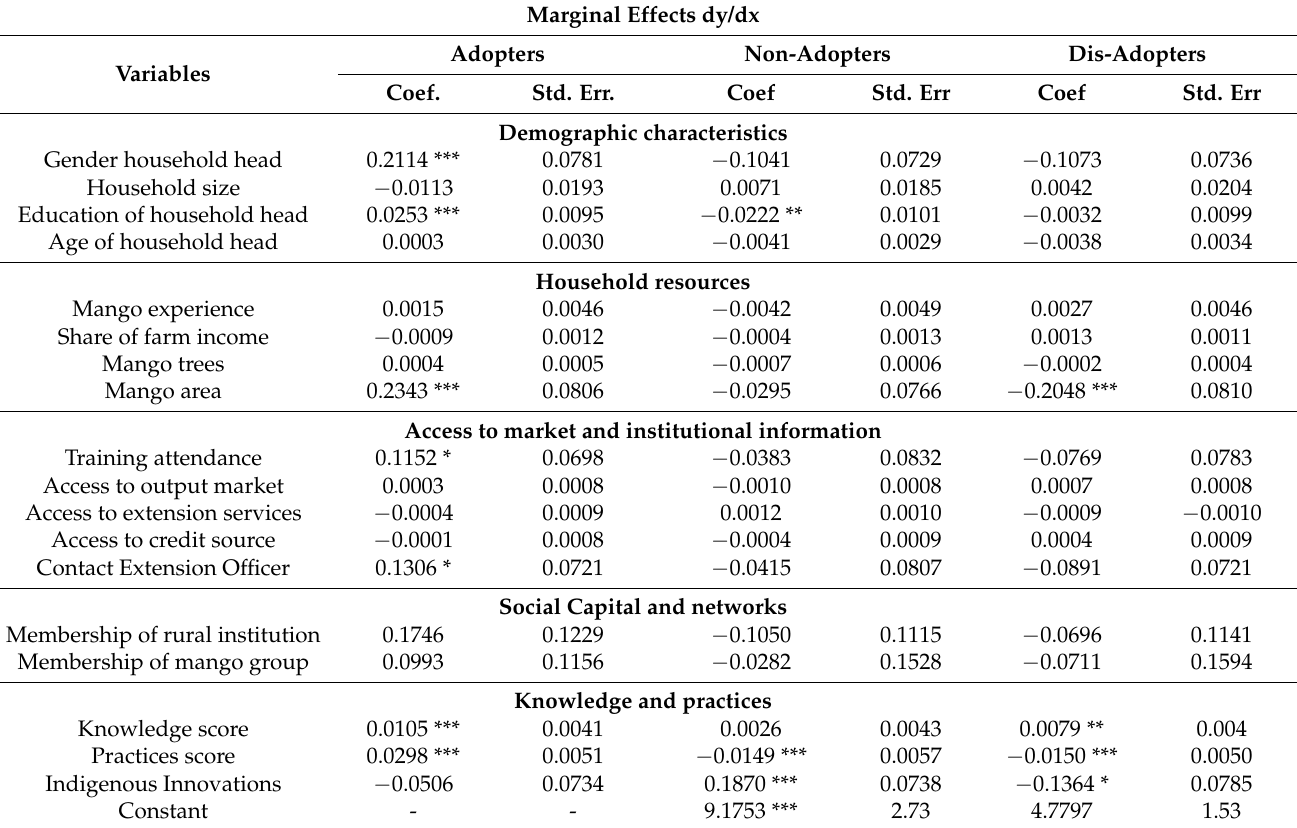
Table 4. Drivers of adoption and dis-adoption of fruit fly IPM strategy in Embu